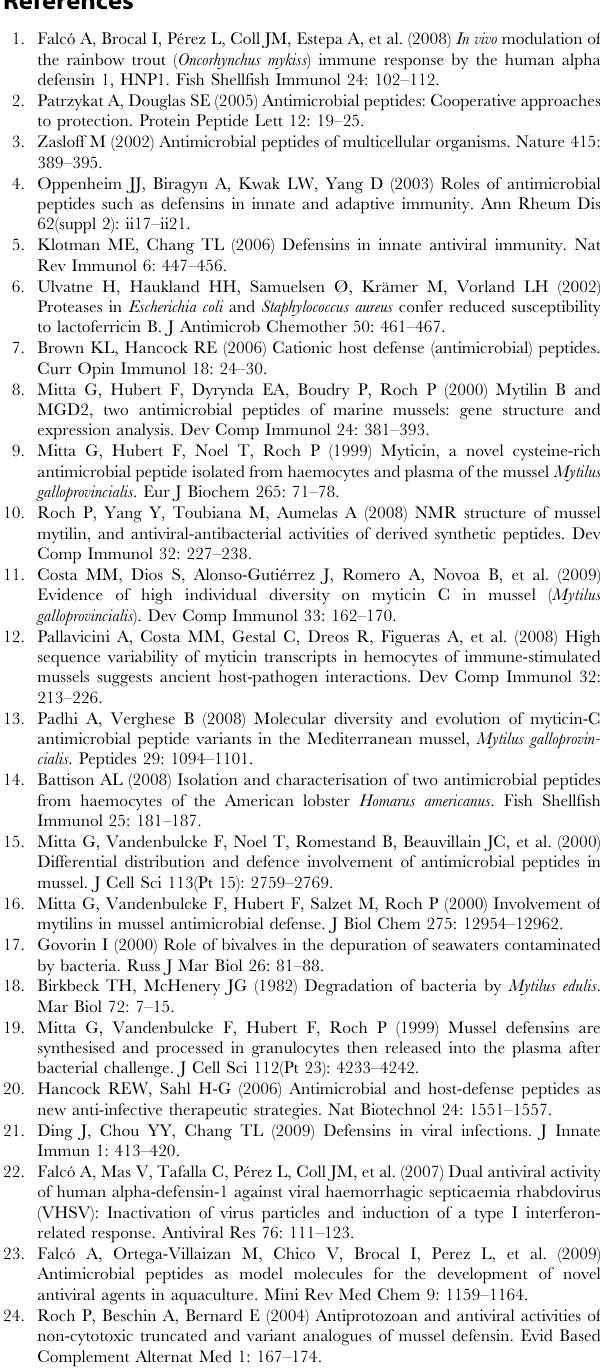
Figure S3 In vitro determination of the subcellular localization of recombinant Myt Cc. Description of data: CHSE cells were transfected with pMCV1.4-Myt Cc-eGFP plasmid and 24 h post transfection washed, fixed and stained with an antiserum anti-Myt C (1), GFP (2) Rho (3) UV (4) merged image of fields 1, 2 and 3. Table S1 Nucleotide sequences of Myt C variants and the antisense ISH RNA cDNA template used in this